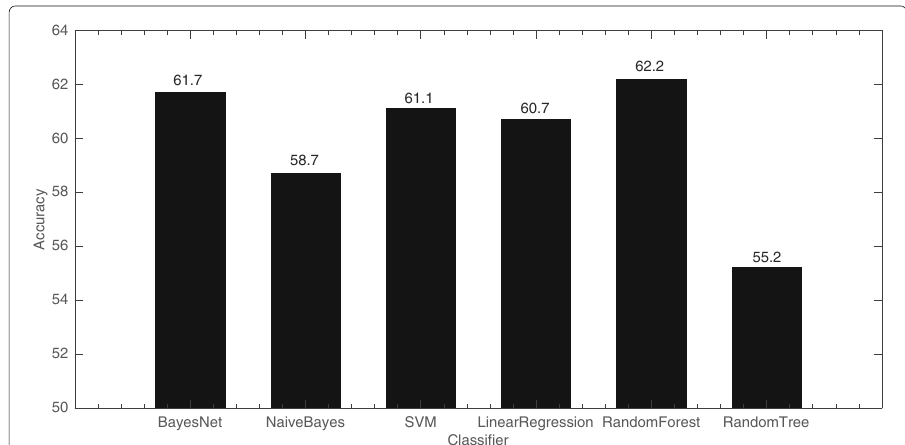
Fig. 3 Traditional statistical features experiment